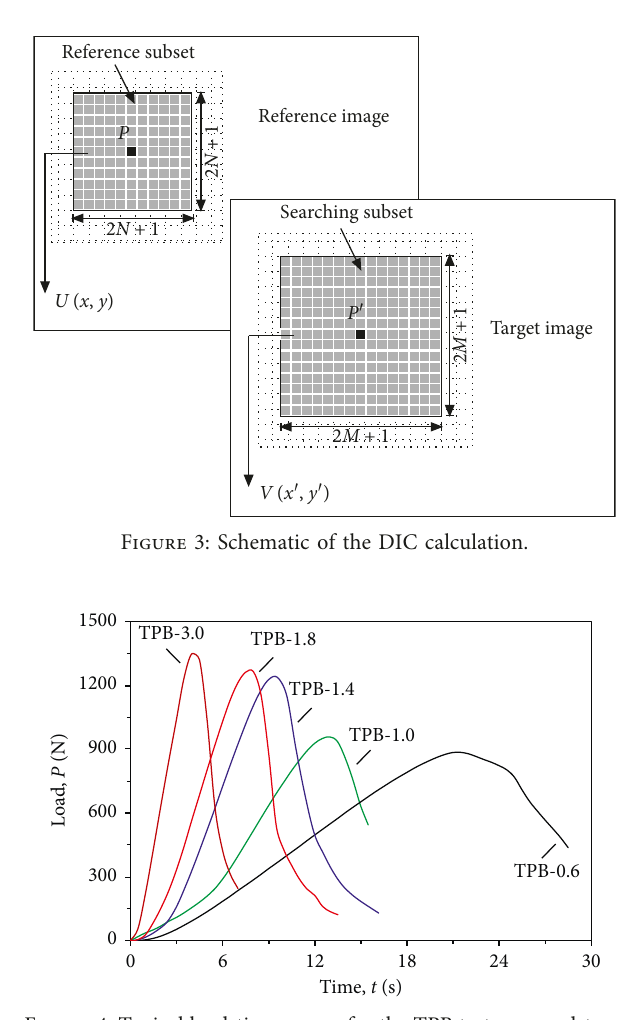
Figure 4: Typical load-time curves for the TPB tests on sandstone specimens under different loading rates.